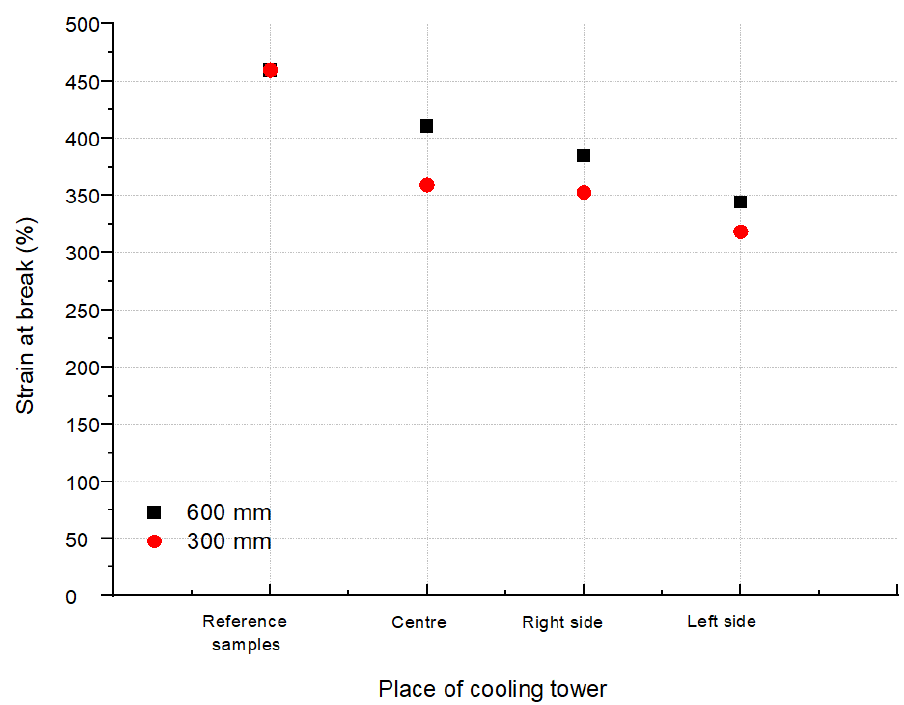
Figure 11. Strain at break from blocks positioned as shown in Figure 2 for CT1.